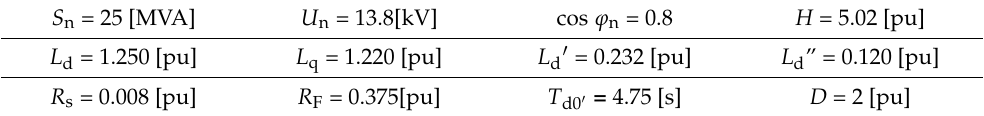
Table A5. Manufacturer’s data: turbo-type synchronous generator S n = 25 MVA.